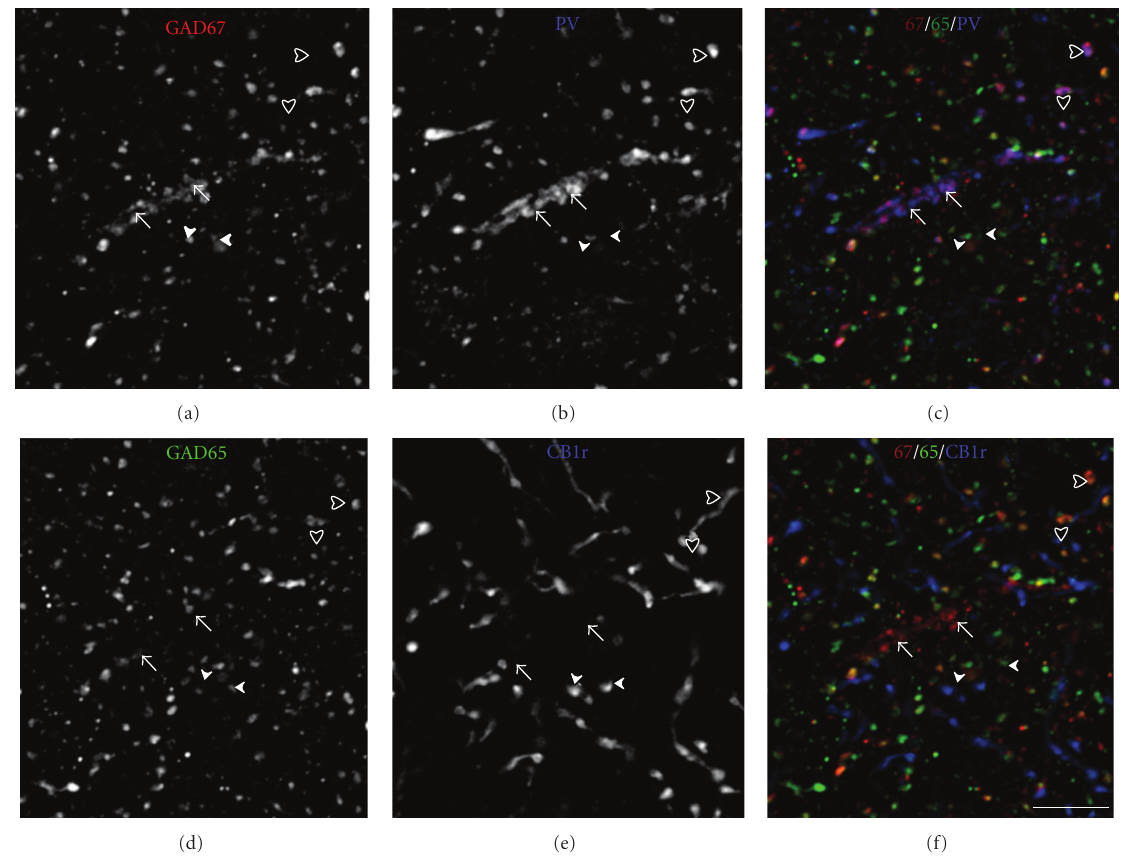
Figure 4: Relative levels of GAD65 and GAD67 in PVCh, PVBC, and CCKBC terminals. Cryostat sections of monkey PFC tissue (40 μ m thick) were quadruple labeled for GAD65, GAD67, PV, and cannabinoid receptor 1 (CB1r). Among inhibitory synaptic boutons, CB1r is exclusively expressed in those CCK-positive neurons and is completely absent in terminals of PV-positive neurons. Presynaptic CB1rs are also present in excitatory synapses; however, the antibody used in the studies illustrated in this figure exclusively reveal CB1r expression in inhibitory boutons (see main text for details). Therefore, CB1r expression is a marker of CCK cell terminals. Single channel (a)-(b) and (d)- (e) and merged (c) and (f) projection images of deconvolved image stacks (2 z-planes 0.25 μ m apart). Since four labels cannot be displayed together in a single image, they have been separated into two RGB images that contain GAD67 (red), GAD65 (green), and PV (blue (c)) or CB1r (blue (f)). Arrows: PV cartridge; solid arrowheads: CB1r + /GAD65 + and GAD67 − terminals; open arrowheads: GAD65 + /GAD67 + /PV + terminals. Bar = 10 μ